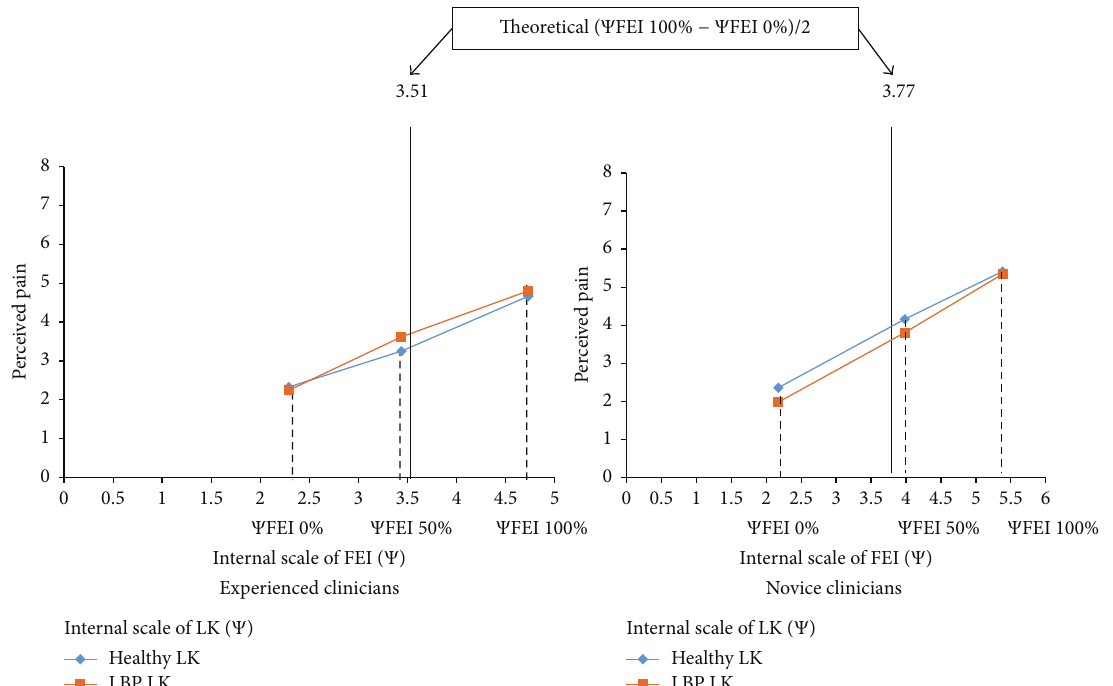
Figure 3: Perceived pain as a function of the internal scale of facial expression intensity (FEI) and of lumbopelvic kinematics (LK), for each